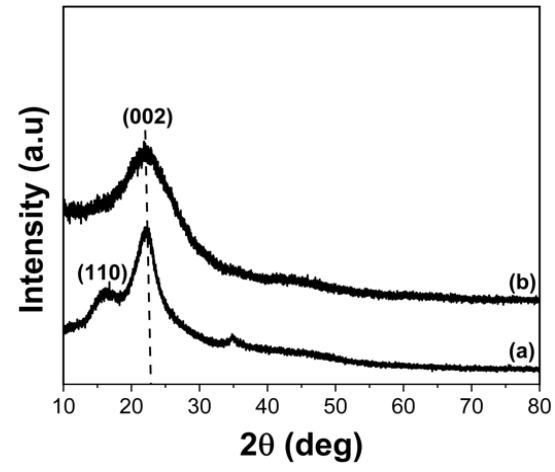
Fig. 2. XRD powder patterns of RH (a) and BC (b)